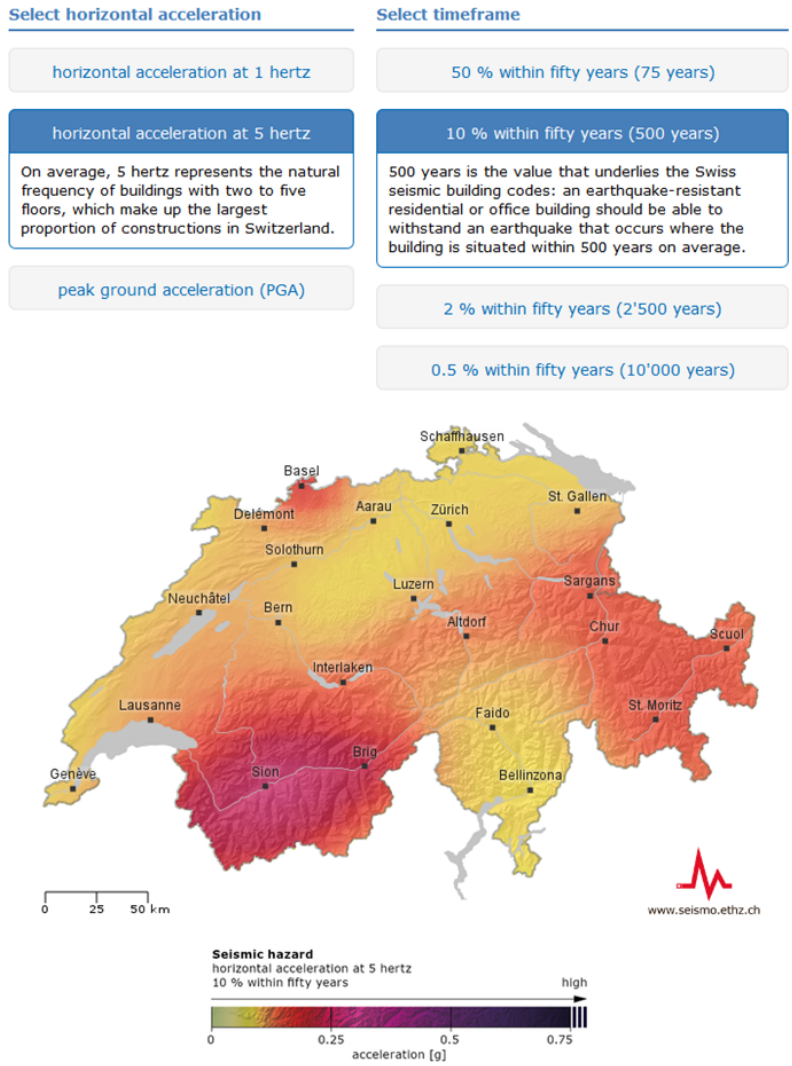
Figure 4. Screenshot of the Swiss seismic hazard model interactive web tool 2015 (Swiss Seismological Service, 2018; http://www.seismo.